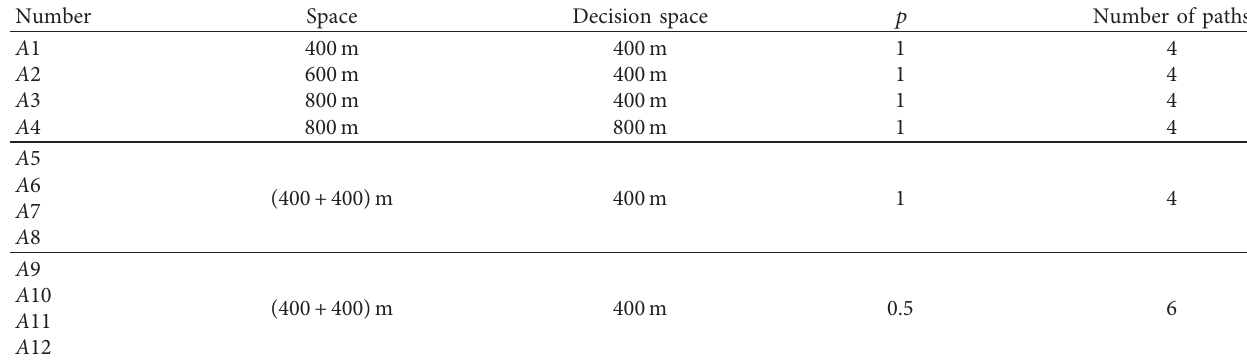
Table 1: Lane-changing simulation